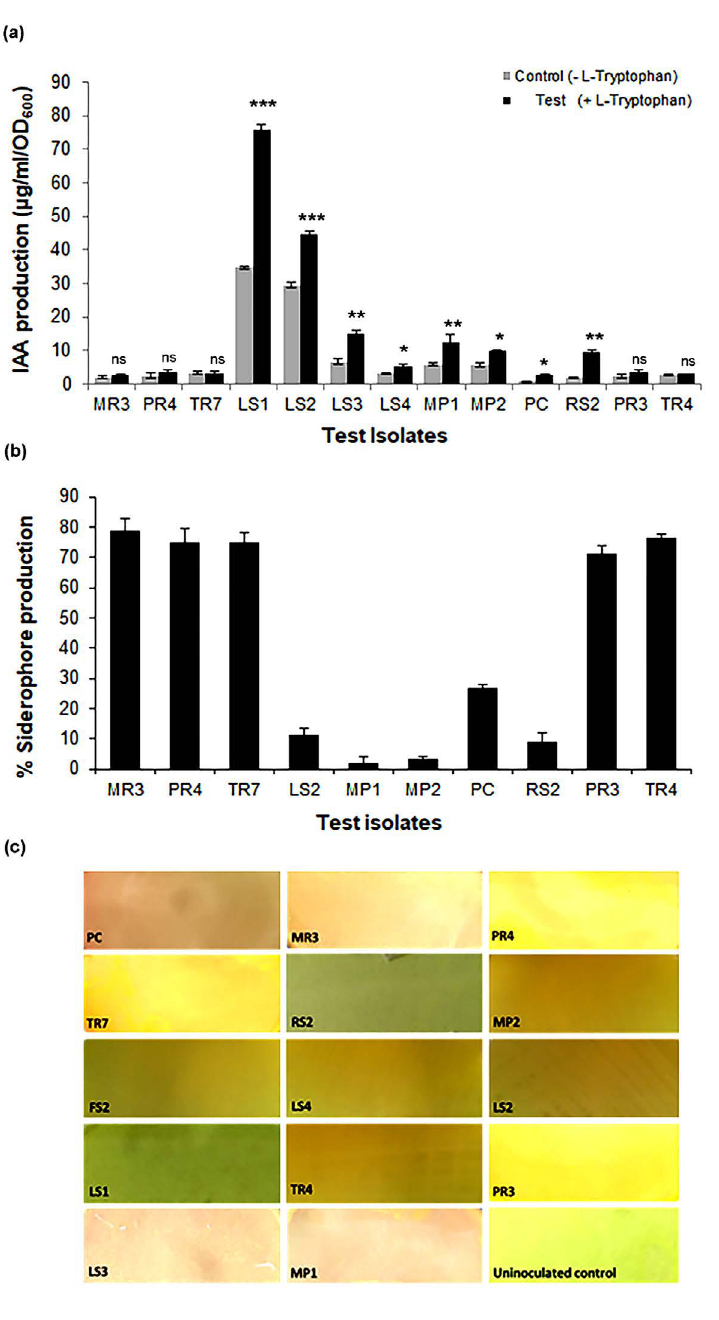
Fig. 2. IAA, siderophore and HCN producing abilities of selected isolates (A) IAA production in presence and absence of L-Tryptophan supplemented in Luria broth. Results are expressed as Mean ± SD of 3 independent observations; *p<0.05, **p<0.01, ***p<0.001 and ns non-significant as compared to the corresponding uninduced control (B) Siderophore production as measured by CAS solution assay, Results are expressed as % siderophore production and values are represented Mean ± SD of 3 independent observations (C) Qualitative determination of HCN producing ability as monitored after 72 h of